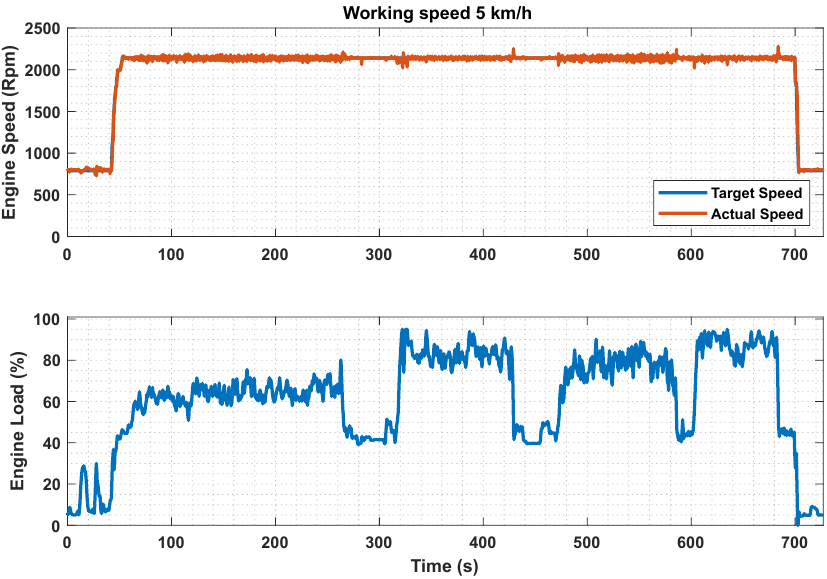
Figure 4. Field test data during work activities with a rotary harrow at 5 km/h.